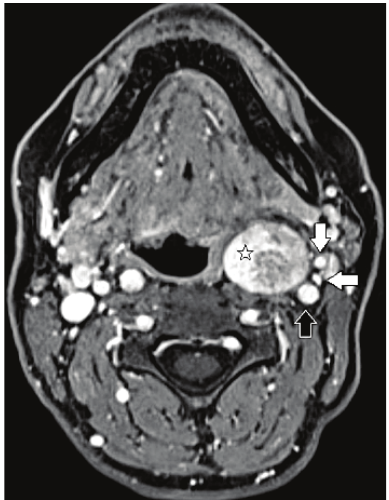
Figure 2: Patient 2, T1-weighted enhanced MRI scan: ovoid mass occupying the left retrostyloid compartment, 3 × 4 cm in size (white star). The internal carotid artery (black arrow), the internal jugularvein(horizontalwhitearrow),andtheexternalcarotidartery (vertical white arrow) are all displaced